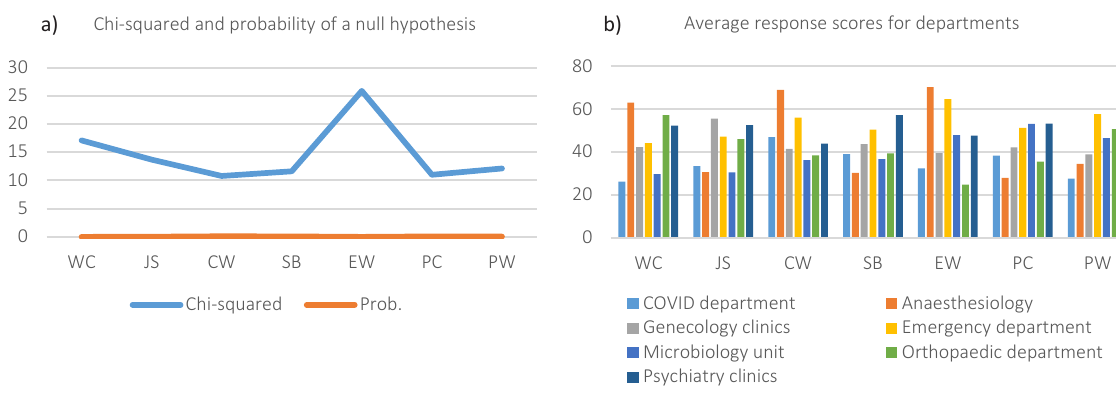
Figure 1. Significant differences between responses of hospital departments (professions) on